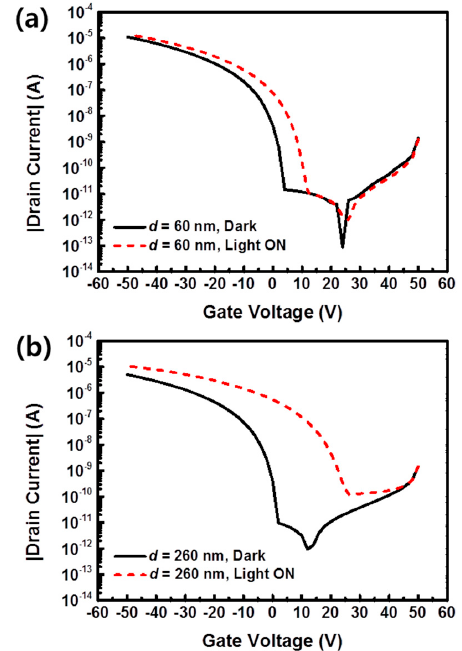
Figure 2. Transfer curves of the OPTs with two different thicknesses, d , of PVP, in the dark and under light exposure; ( a ) d = 60 nm and ( b ) d = 260 nm. light exposure; ( a ) d = 60 nm and ( b ) d = 260